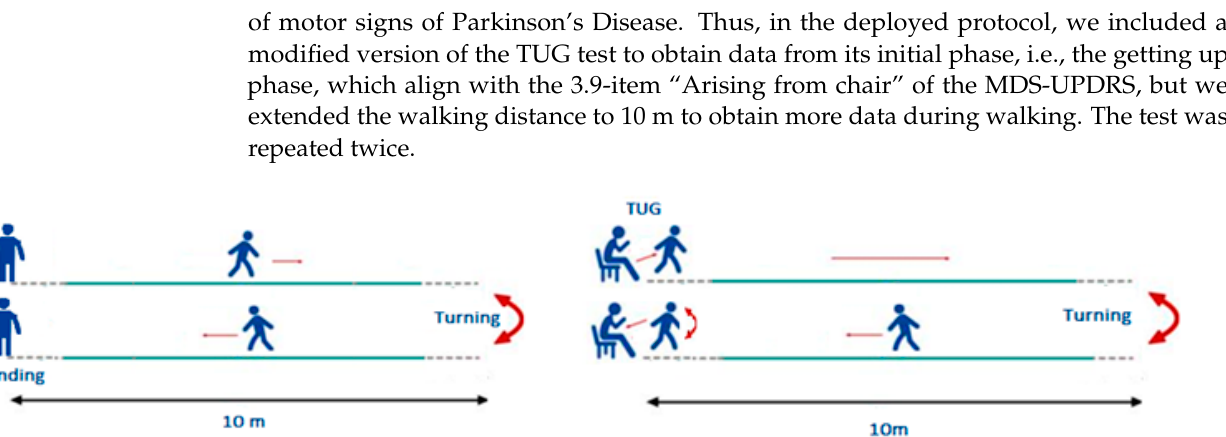
Table 1. The details of Smart-Insole’s Dataset